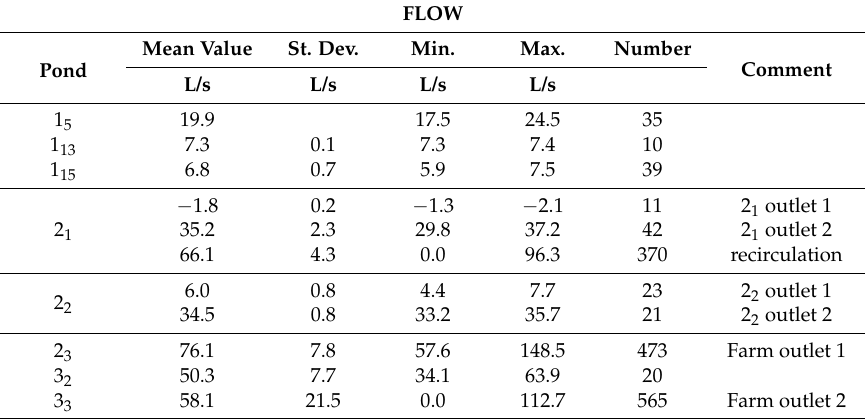
Table 2. Outcome of flow data measured on the selected fish farm locations at the moment of the experiment. Standard deviation (St. Dev.); Minimum (Min.); Maximum